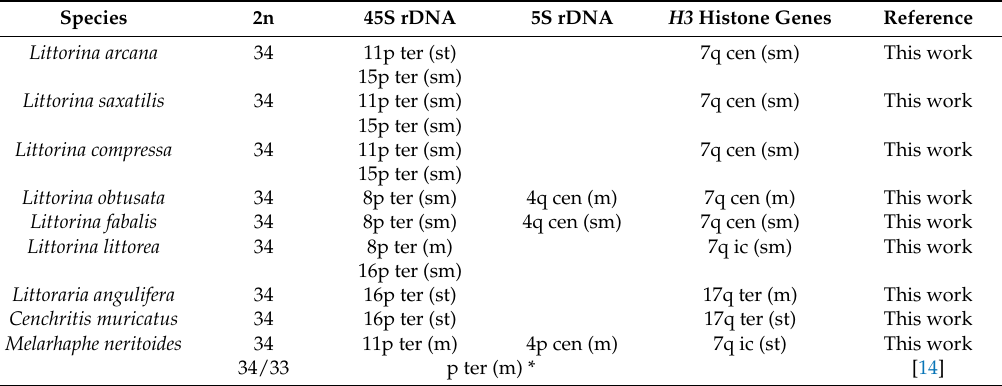
Figure 3. Chromosomal mapping of rDNA and histone gene clusters in mangrove, beaded, and small periwinkles. Fluorescent in situ hybridization mapping of H3 histone gene (H3, green) and major rDNA (28S, magenta) probes to mitotic chromosomes of the mangrove periwinkle Littoraria angulifera , the beaded periwinkle Cenchritis muricatus , and the small periwinkle Melarhaphe neritoides counterstained with 4 ′ -6-diamidino-2-phenylindole (DAPI). Minor rDNA (5S, red) signals were also detected in the small periwinkle. Scale bars, 5 μ m. Table 3. Chromosomal location of rDNA and histone gene clusters in Littorinidae.